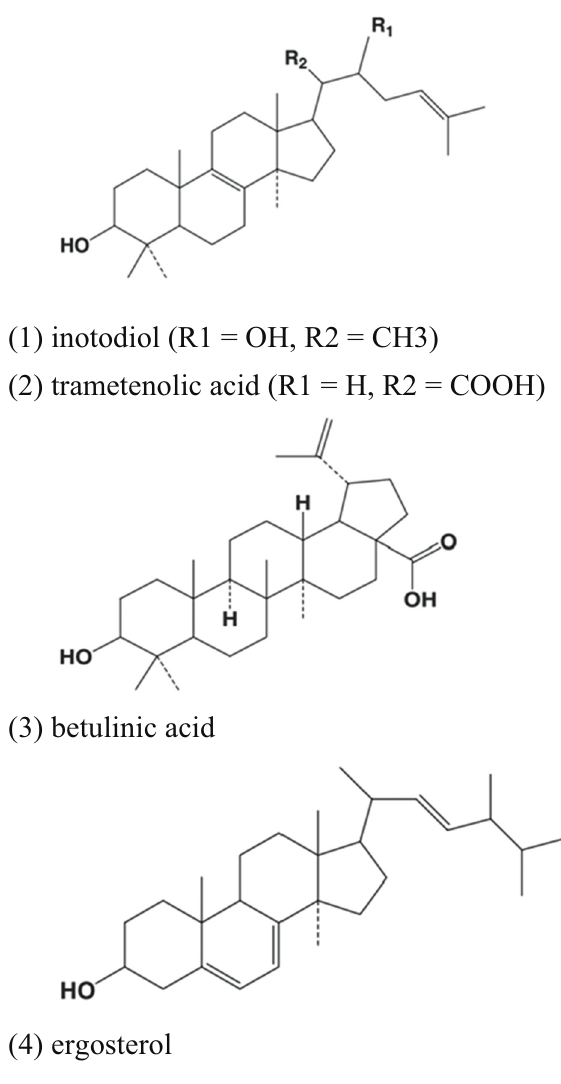
Figure 3: The structures of compounds 1 –